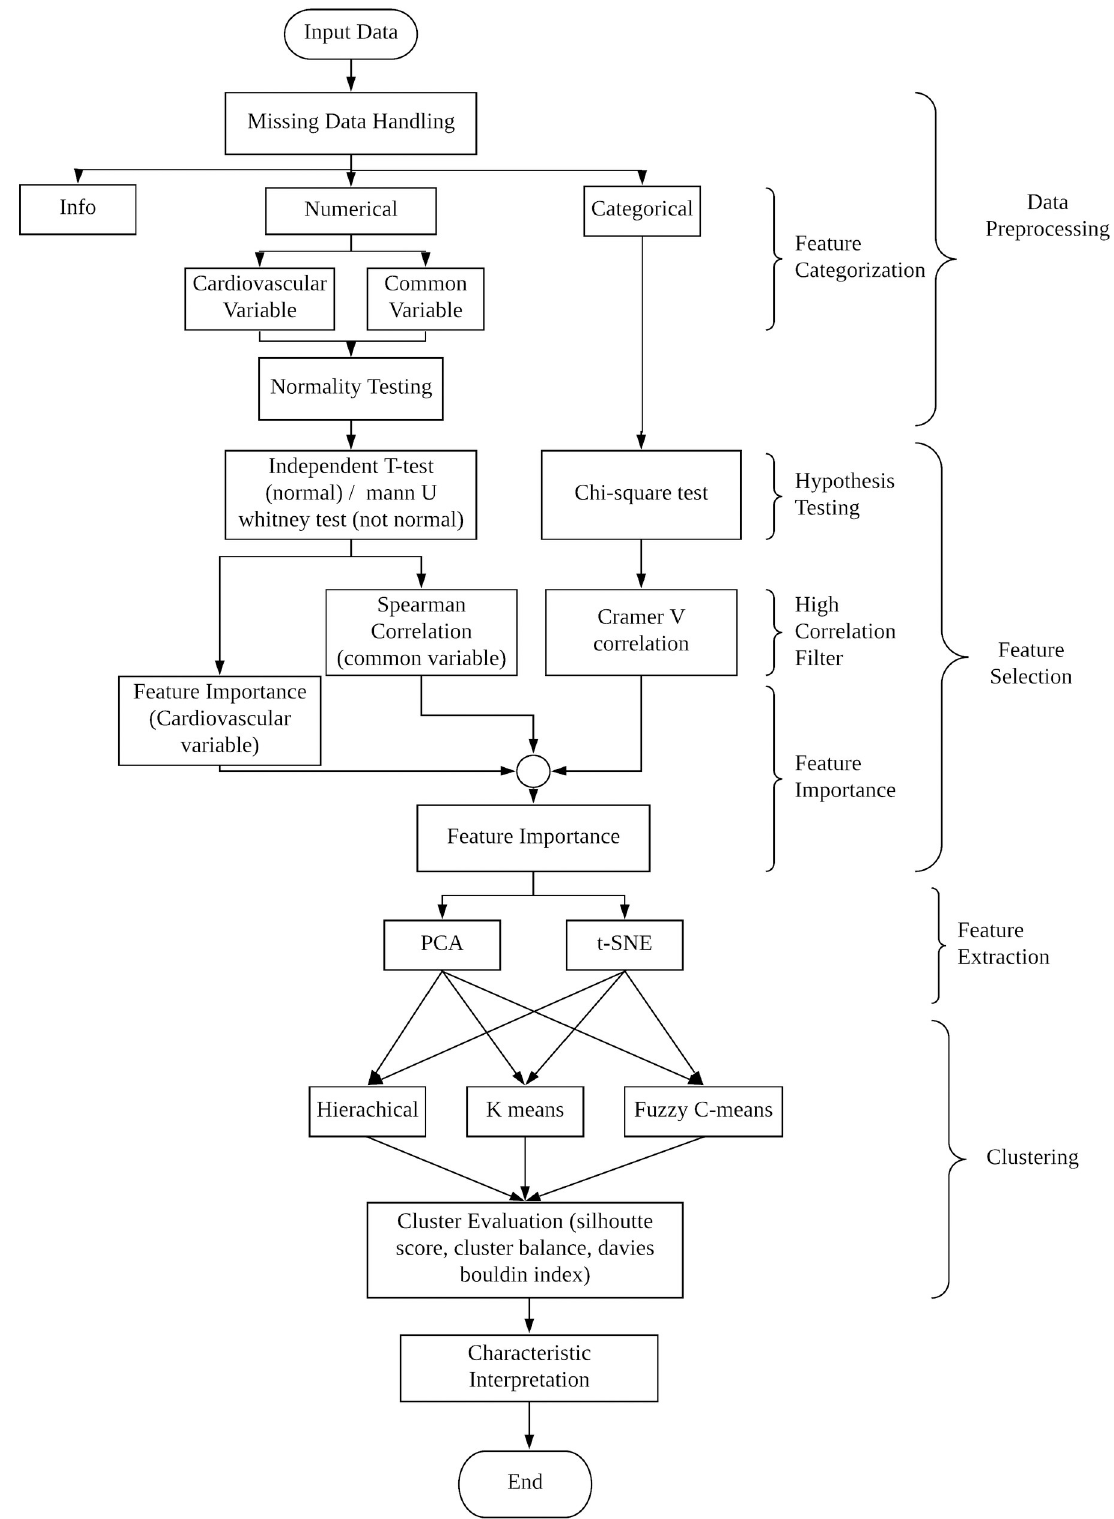
Fig 1. System flow diagram of the study. The input dataset was imported and analysed. In the data pre-processing stage, after missing data handing, data were categorized different categories. Numerical data were further examined with normality test and a series of feature